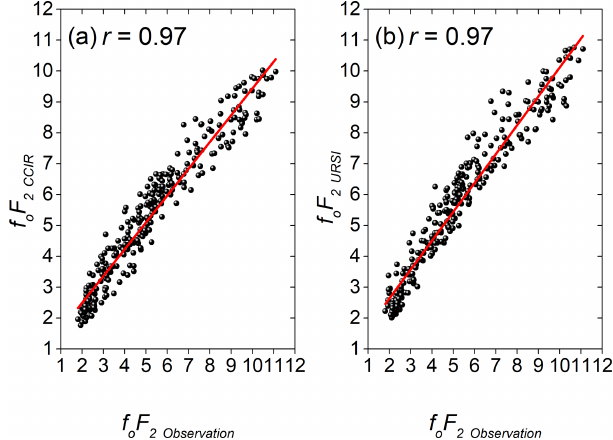
Figure 2. Scatter plots depicting the comparison be- tween (a) fo F2 CCIR and (b) fo F2 URSI versus fo F2 Observation